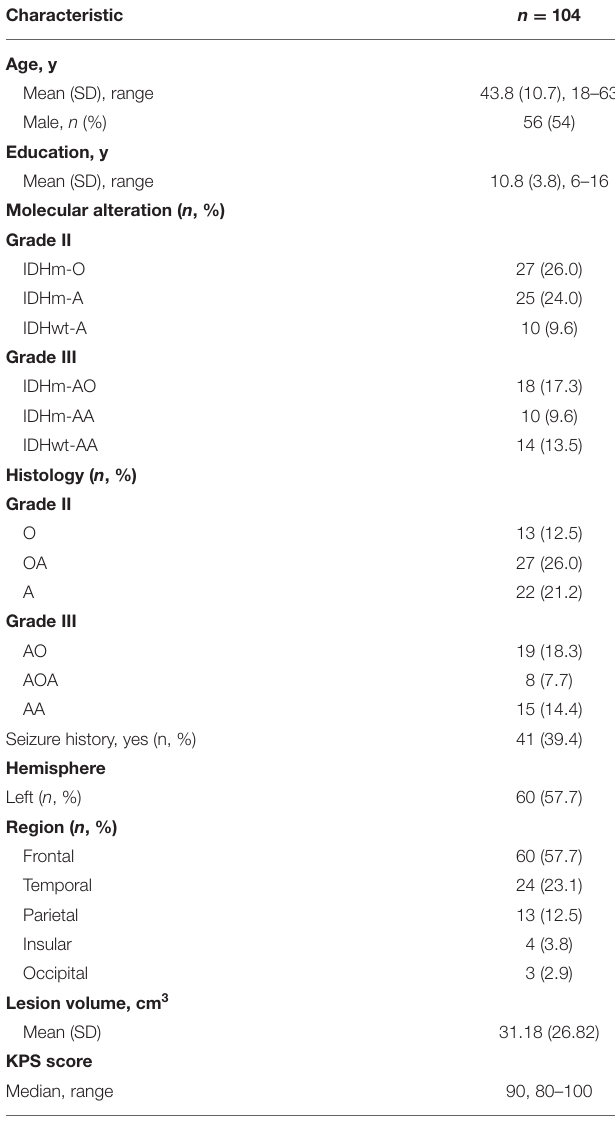
TABLE 2 | Demographic and clinical